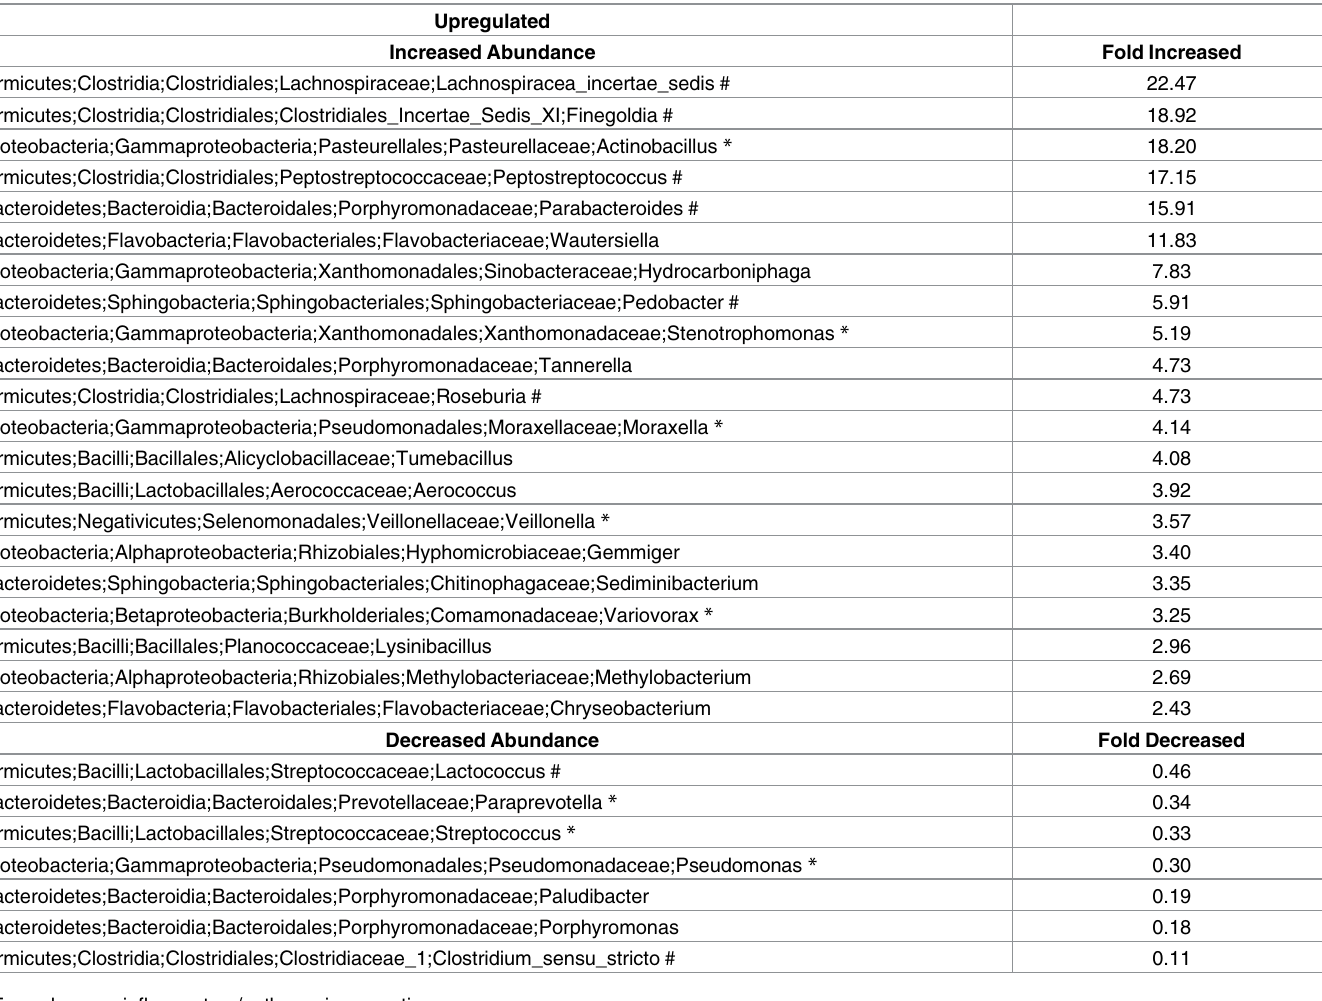
Table 3. Bacterial taxa up-regulated and down-regulated in obese compared to lean